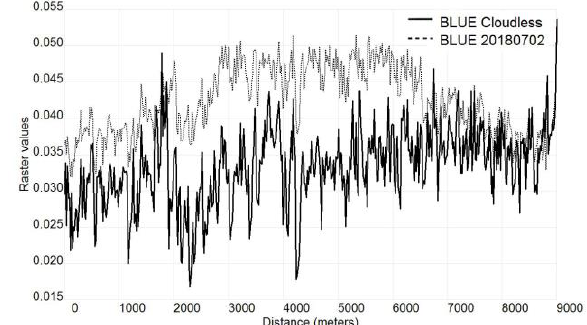
Figure 14. Spectral profile of the Blue band reflectance along a transect for both reconstructed image and reference